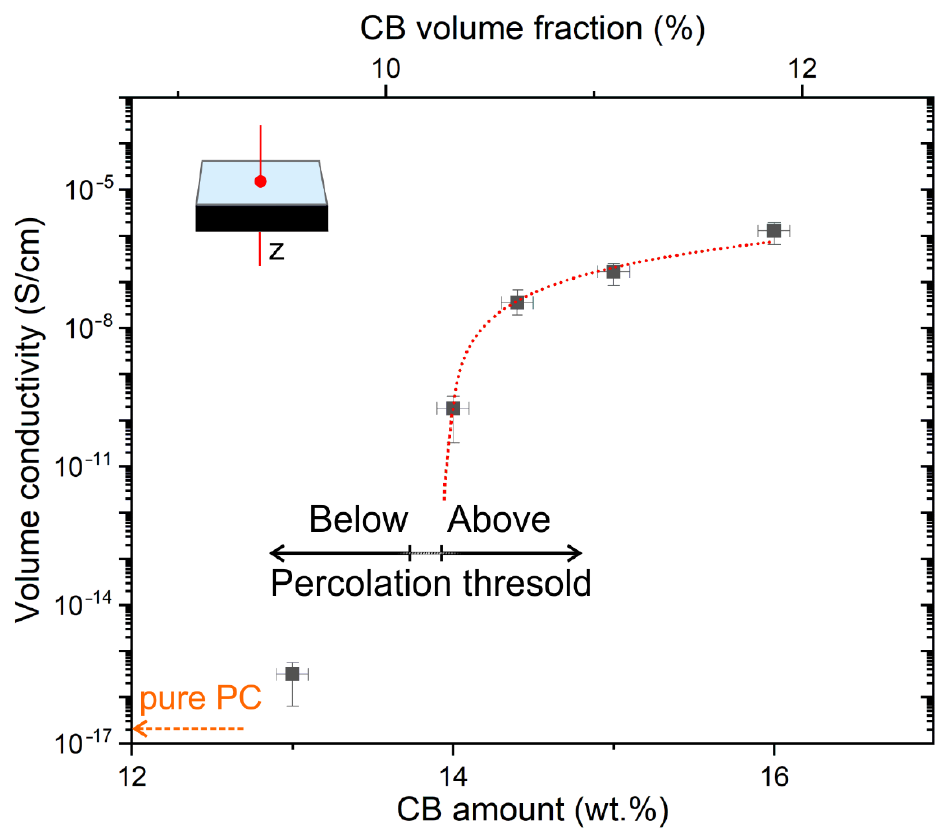
Figure 3. Room temperature conductivity as a function of the CB loading in CB-filled melt-compounded PC composites.